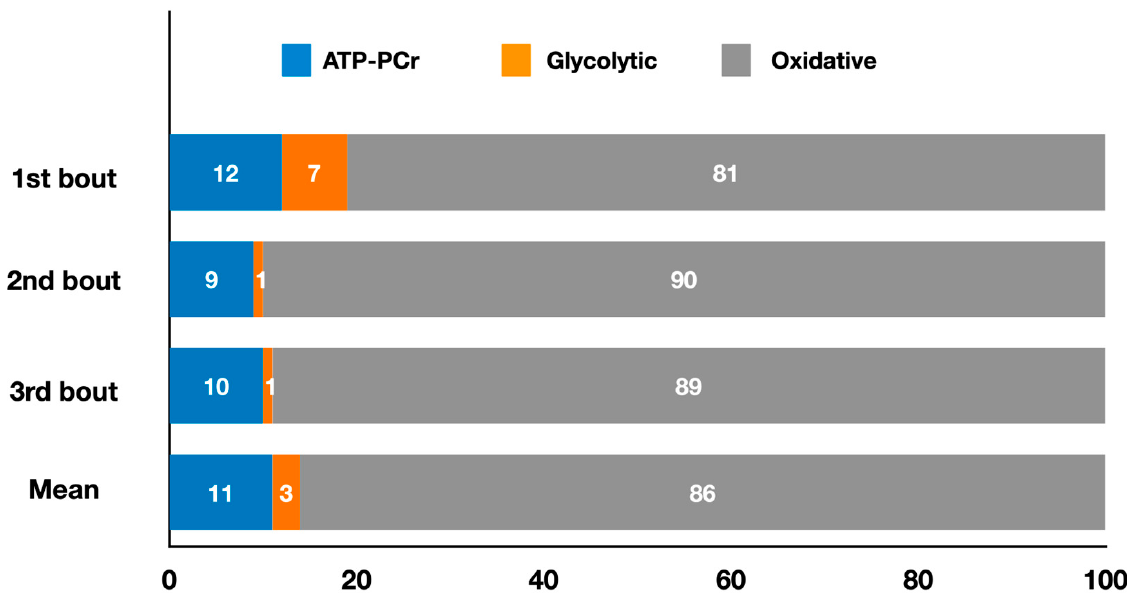
Figure 5. Contributions of the oxidative, ATP-PCr, and glycolytic systems during three 3 min fencing é p é e matches, and the mean contributions throughout the entire match (adapted from Yang et al. [18]). The values represent the mean percentage of each energy system for each round and for the entire match simulation (refer to the text for specific comparisons between energy